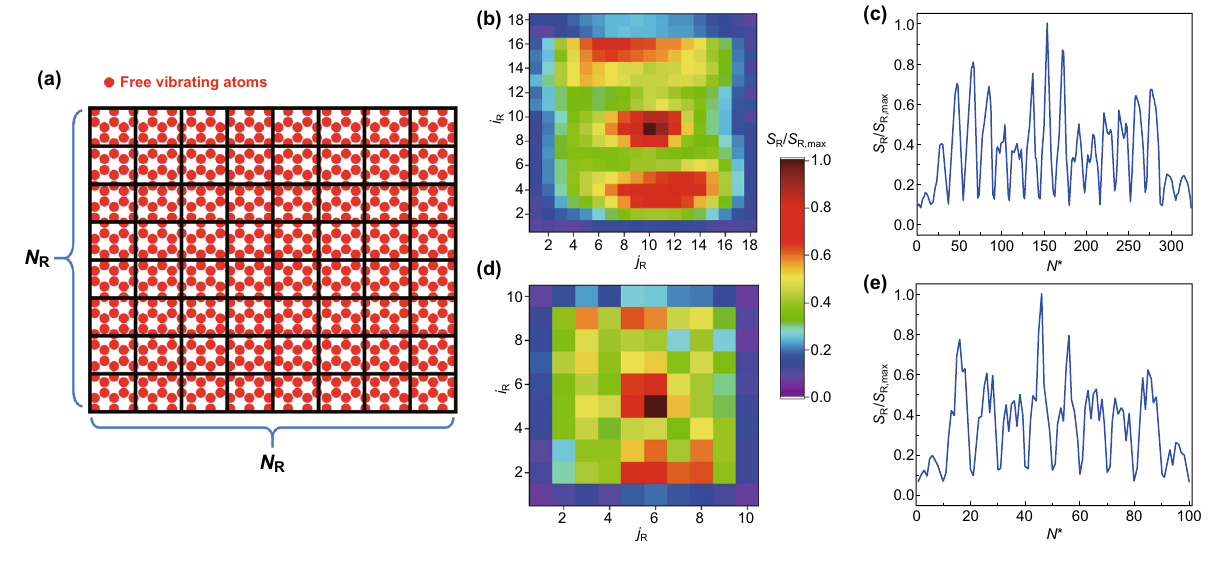
Fig. 3 Domain discretization of a graphene sheet. a Schematic of an N R -by- N R uniform domain discretization. b 2D energy distributions by 18-by-18 discretization converted from the atom-based energy vector in Fig. 2a. c 1D energy vector compressed from 18-by-18 discretization in ( b ). d 2D energy distribution of 10-by-10 discretization converted from the atom-based energy vector in Fig. 2a. e 1D energy vector compressed from 10-by-10 energy discretization in ( d